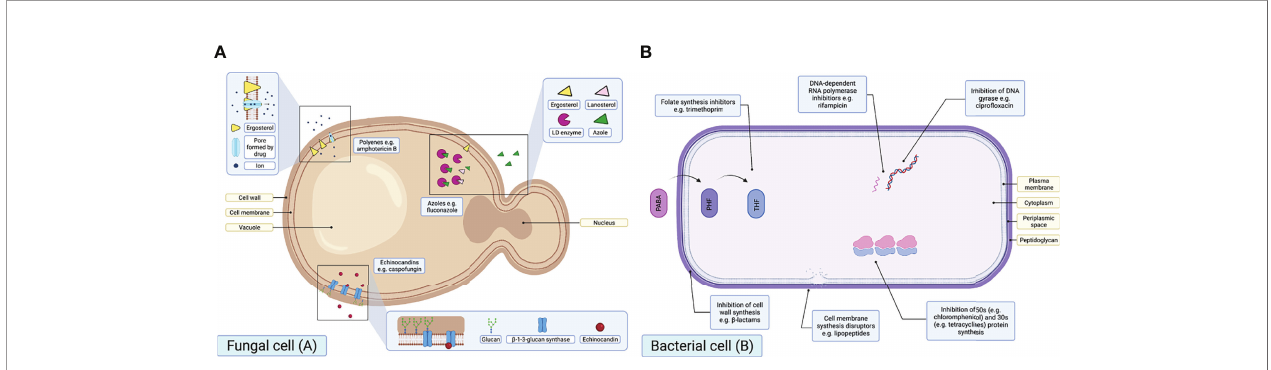
FIGURE 2 | Schematic diagrams illustrating the MoAs of the primary antifungal drug classes in a fungal cell (A) and primary antibacterial drug classes in a bacterial cell (B) . PABA, para-aminobenzoic; DHF, dihydrofolic acid; THF, tetrahydrofolic acid [adapted from Sanseverino et al. (2018)]. Created with